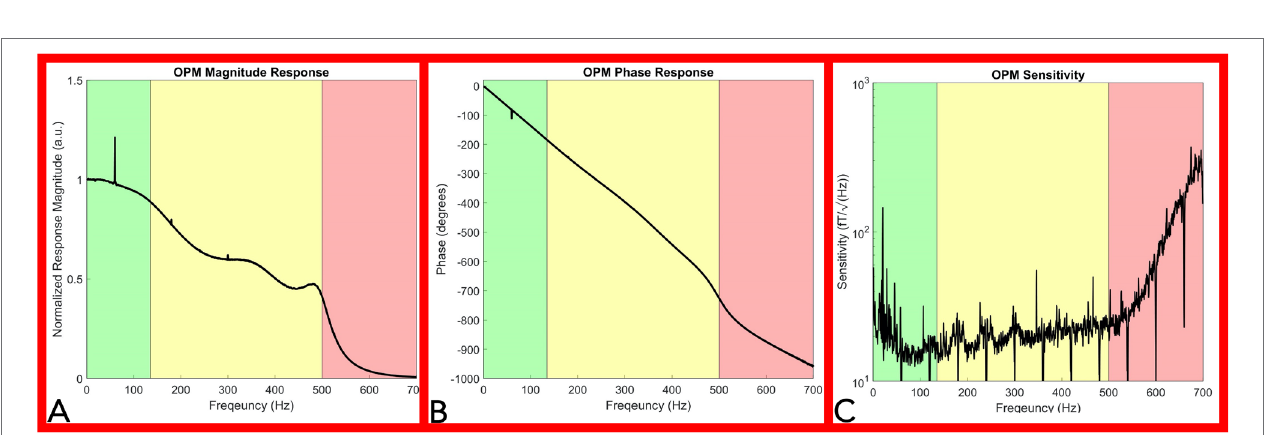
FIGURE 4 | OPM frequency response and sensitivity characterization. Panel (A) : Magnitude Response of the OPM. The OPM magnitude response decreased minimally up to 135Hz (green shaded area). A moderate reduction in response was recorded up to 500Hz (yellow shaded area). Above 500Hz, a large reduction in response is noted as a direct effect of the Gen2 OPM hardware digital filter in the electronic module (red shaded area). Panel (B) : Phase response of the OPM. OPM Phase response is approximately linear up to 500Hz (green and yellow shaded area). Panel (C) : Sensitivity response of the OPM. OPM sensitivity was divided into three segments: below 135Hz (green shaded area), from 135 to 500Hz (yellow shaded area), and from 500 to 700Hz (red shaded area). A rapid decrease in sensitivity is noted above 500Hz. (OPM, Optically pumped magnetometer, Hz, Hertz, and fT,